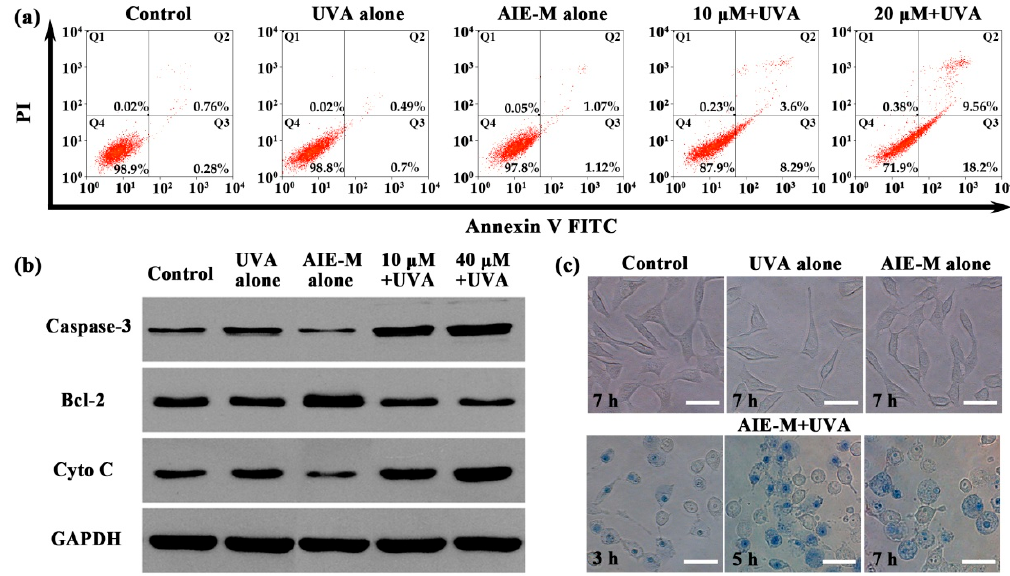
Figure 10. ( a ) Apoptosis of HeLa cells analyzed by flow cytometry; ( b ) Western blot analysis for the determination of the release of cytochrome c and expression of caspase-3 and Bcl-2 by the HeLa cells after PDT; ( c ) Bright-field images of HeLa cells counterstained with trypan blue. The scale bar is 40 μ m.